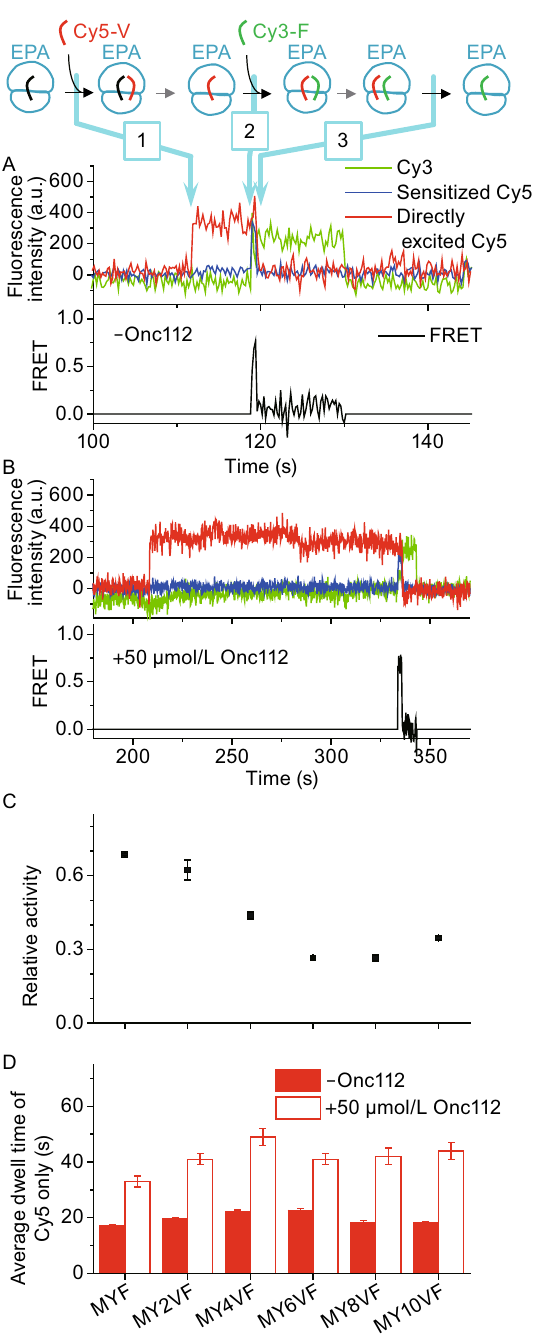
2015). On the other hand, translocation rate in the second elongation cycle of ribosomes programmed with MVF, cal- culated from dwell time of high L11-tRNA FRET state (Fig. 1E between arrows 4 and 5), increased from 0.49 ± 0.01 s − 1 to 1.23 ± 0.03 s − 1 in the presence of Onc112 (Fig. 1F and 1H). We found that conformational dynamics of ribosomal PRE-translocation (PRE) complexes prior to translocation were also affected by Onc112. 50 μ